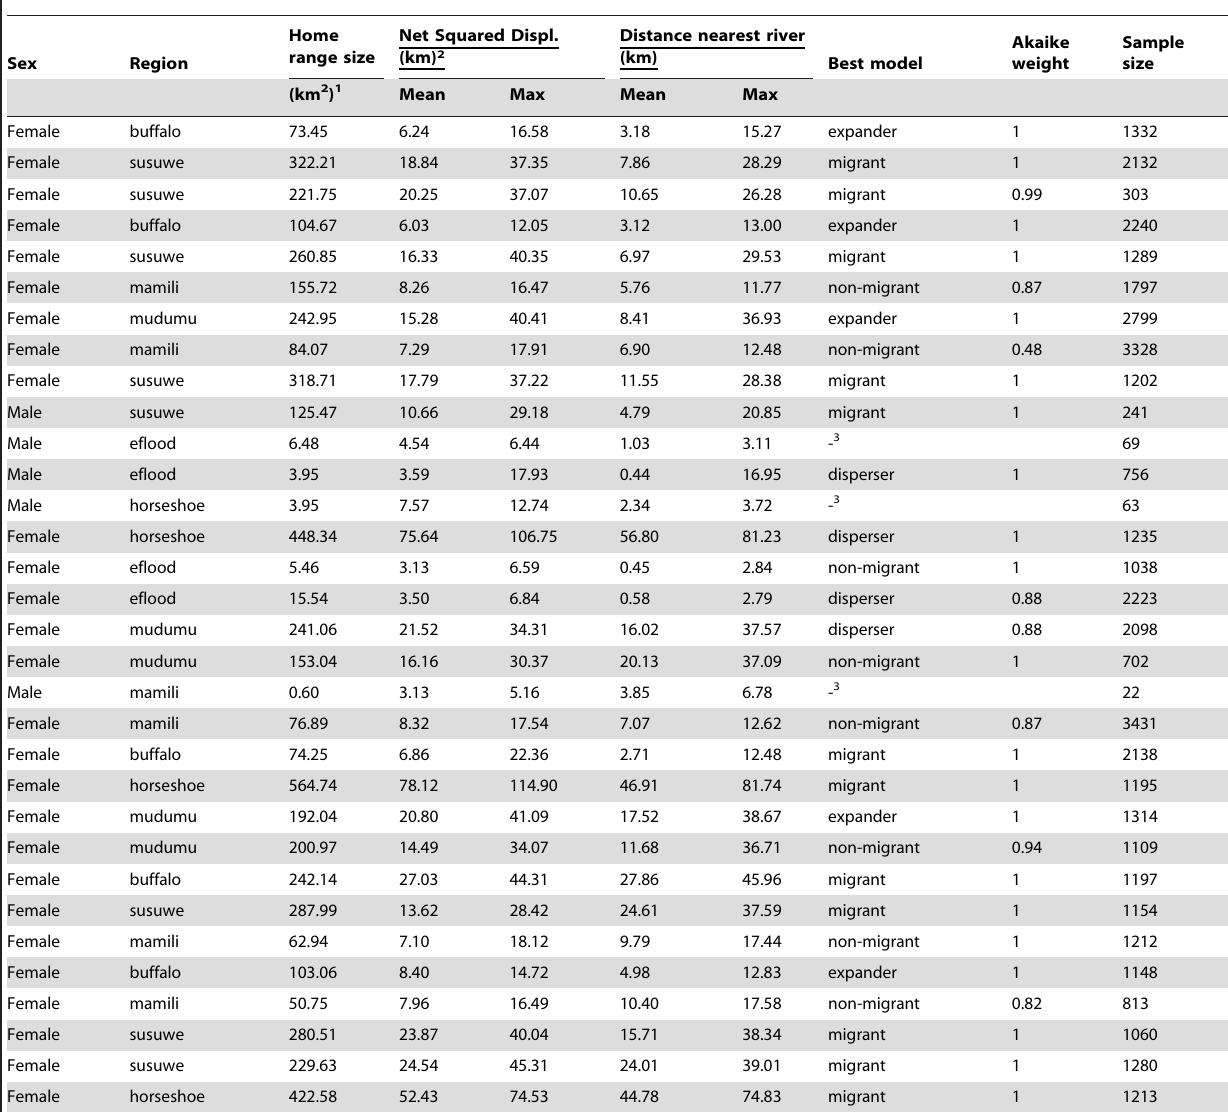
Table 1. Descriptive statistics from n =32 GPS chronosequences from African buffalo in the Caprivi Strip of Namibia.